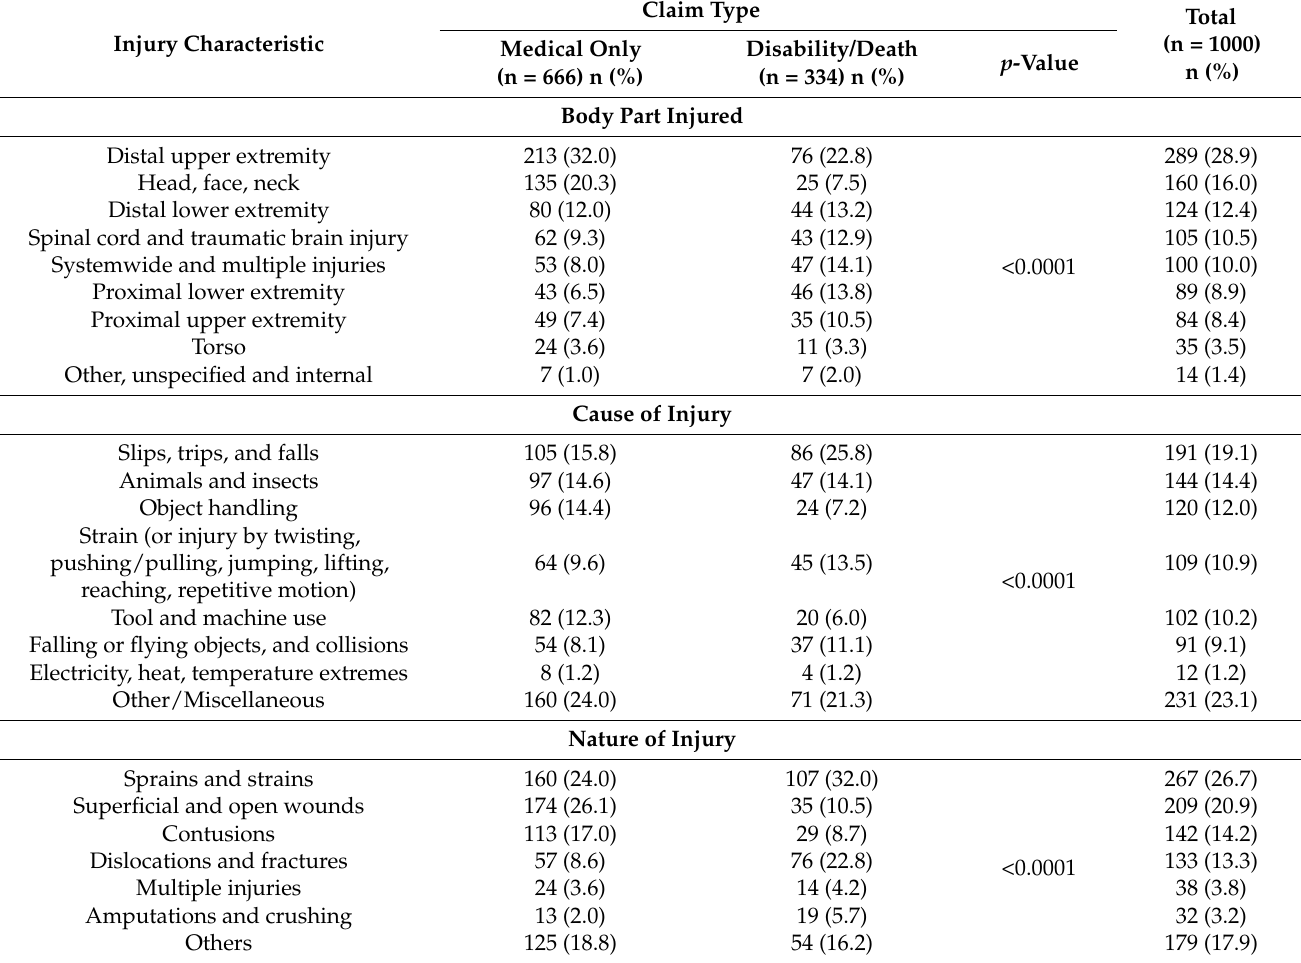
Table 1. Body part injured, cause of injury, and nature of injury by claim type (medical only and disability/death) (n = 1000). Injury Characteristic